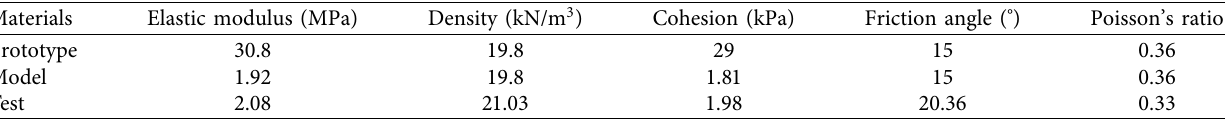
Table 13: Comparison of physical mechanical parameters for silty clay.